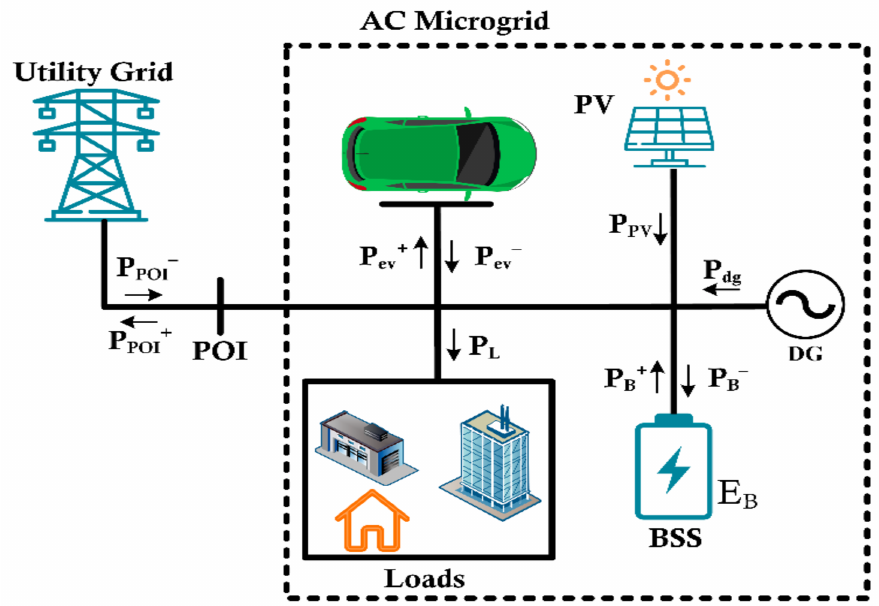
Figure 2. The scheme of the considered MG: illustration of MG boundaries and positive power